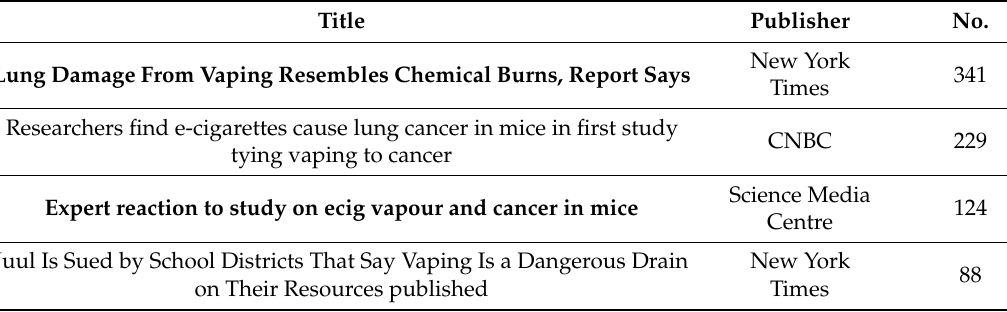
Table 5. Most frequently occurring hashtags.